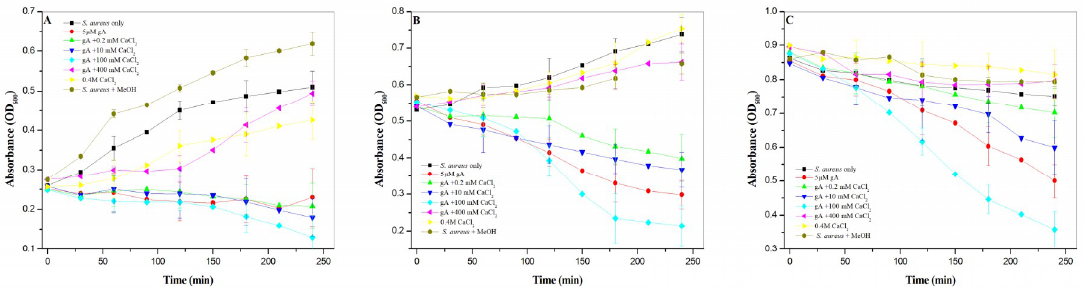
Figure 8. The antimicrobial activity of gramicidin A in the presence of CaCl 2 ( A – C ). In the antimicrobial activity assay, stock solutions were prepared containing 100 µ M gramicidin A with 0, 0.2, 10, 100 and 400 mM CaCl 2 in methanol. The stock solutions were then diluted into S. aureus culture with a final solution containing 5 µ M gramicidin A. ( A ), lag phase; ( B ), exponential phase; and ( C ), stationary phase.